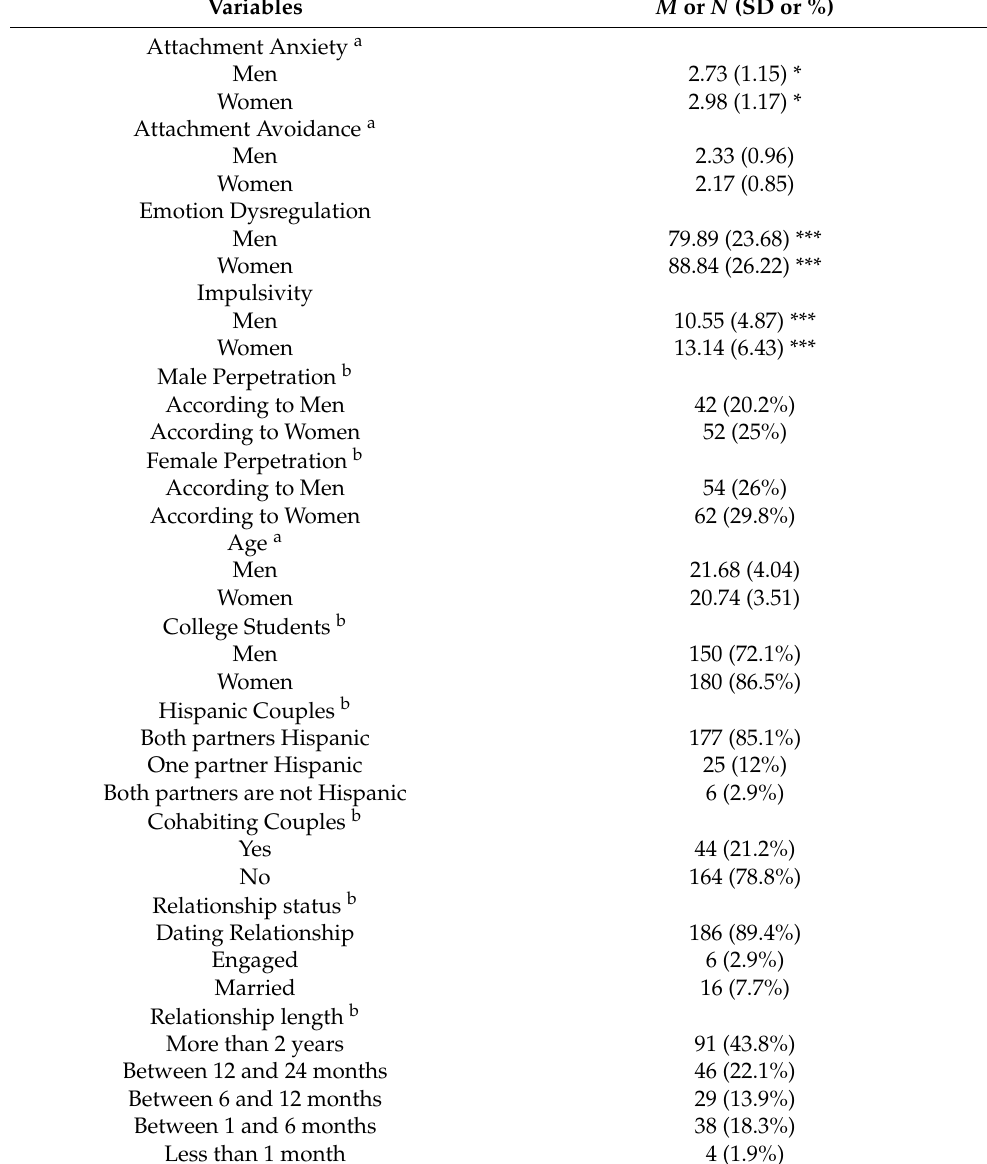
Table 1. Descriptive statistics for study and demographic